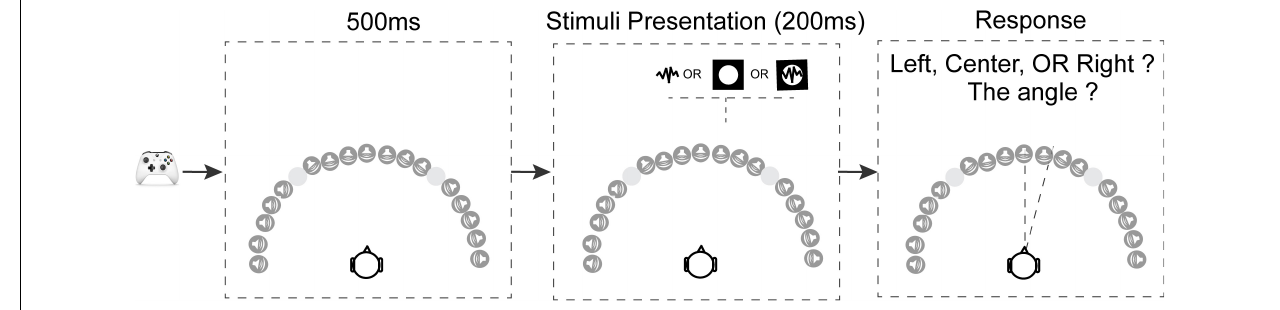
FIGURE 2 | Schematic of the trial structure. Subjects used an Xbox controller to initiate each trial. After the key press there was a 500 ms delay, followed by a stimulus presented from one of the seventeen locations. There were four stimulus conditions: in the vision-only condition a white disk was presented for 200 ms; in two audition conditions (with or without blindfold) pink noise was presented for 200 ms; in the audiovisual condition the white disk and pink noise were presented simultaneously from the same location for 200 ms. After the target presentation, the subjects needed to verbally report the location of the stimuli, first responding left or right, then responding with an angle relative to directly in front of the subject. The –40 ◦ and 40 ◦ locations were omitted because these locations were at the intersection between the screens where visual stimuli can’t be presented